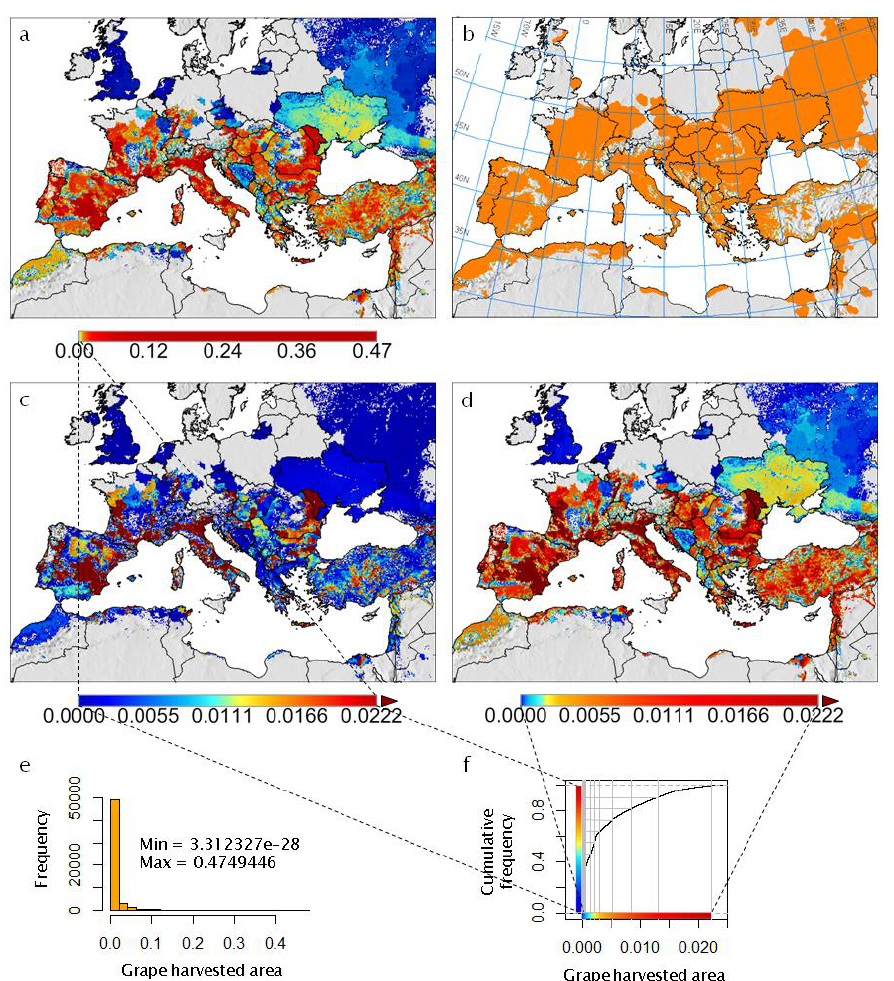
Figure 3. Analysis of the observed geographic distribution of grape production for the reference year 2000 using the fraction of ~10 km × 10 km cell covered by vineyards (data from [62]) mapped only if fraction is ≥0.0001 (i.e., each raster cell that covers ~10 4 ha of land is considered part of the grape growing area if it includes at least one ha of vineyard): ( a ) map with histogram-equalized color coding ( f ) where each color covers an equal share of land; ( b ) derived potential grape distribution with uniform color to highlight the grape growing area (note that missing data for Sicily in [62] were filled using Corine Land Cover 2000 raster data [63]); ( c ) map where statistical outliers selected via the boxplot R function [15] are mapped in very dark red (i.e., symbol ► ) to improve visual detection of differences within non-outlier data [64]; ( d ) map with histogram-equalized color coding restricted to non-outlier data, and where each color covers an equal share of land but only for areas covered by non-outlier data cells ( f ); ( e ) frequency histogram of data in ( a – d ); ( f ) cumulative frequency used to assign an equal number of cells to every color in the legend of plot ( d ).